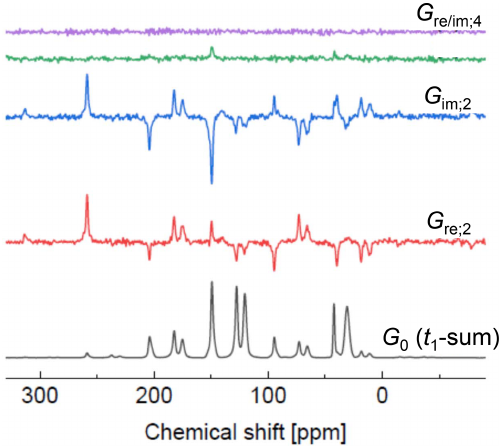
Figure 9. Spectra along ω 2 (in ppm) encoding the t 1 Fourier coef- ficients as indicated. The lowest spectrum is the sum of all slices in t 1